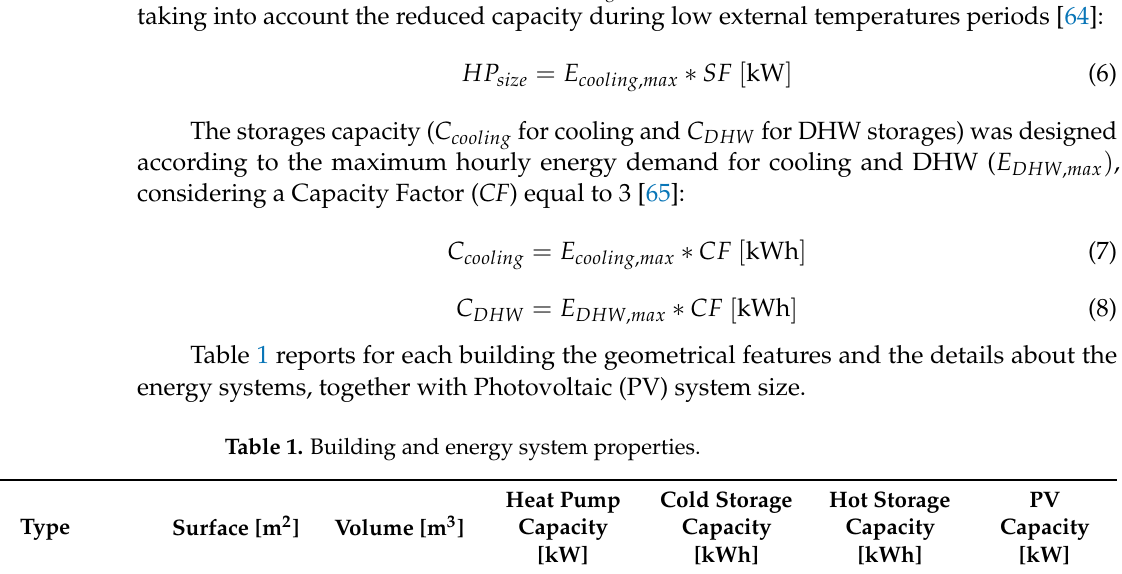
Table 1. Building and energy system properties.